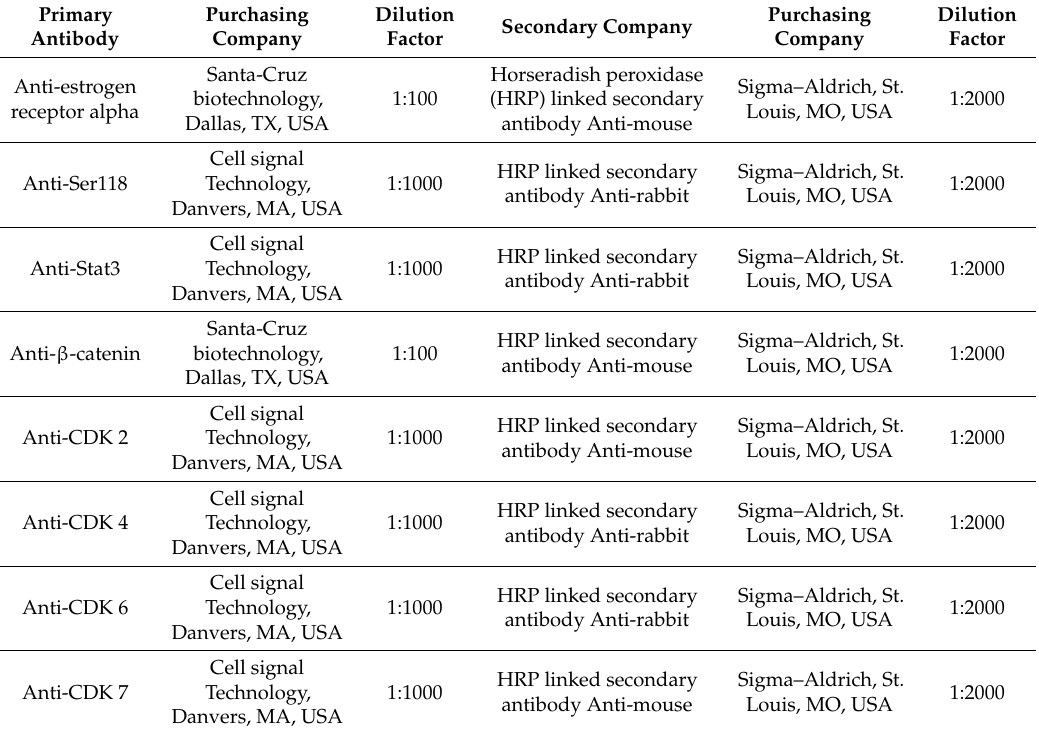
Table 2. Antibodies information